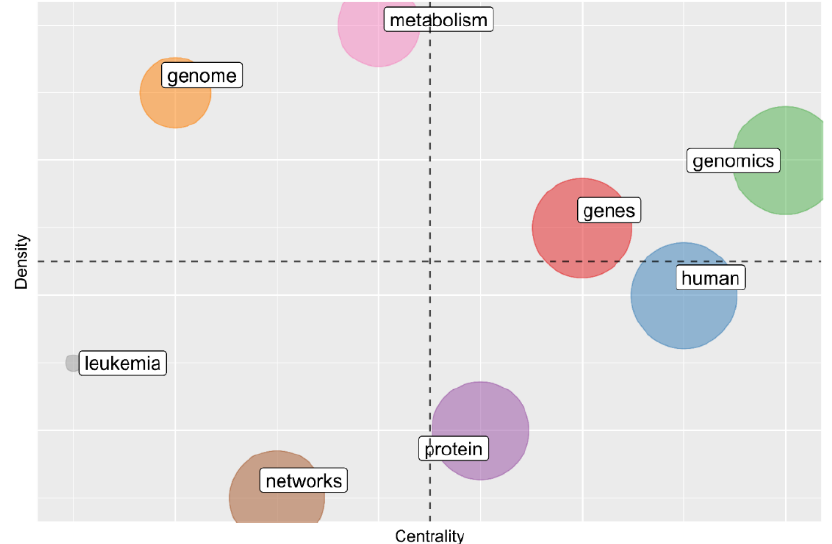
Figure 5. Thematic map of Mexican bioinformatics corresponding to the 1994–2018 period. The circle area represents the abundance of a theme in the literature. The X -axis represents Callon’s centrality of the themes in the network, and the Y-axes the density.